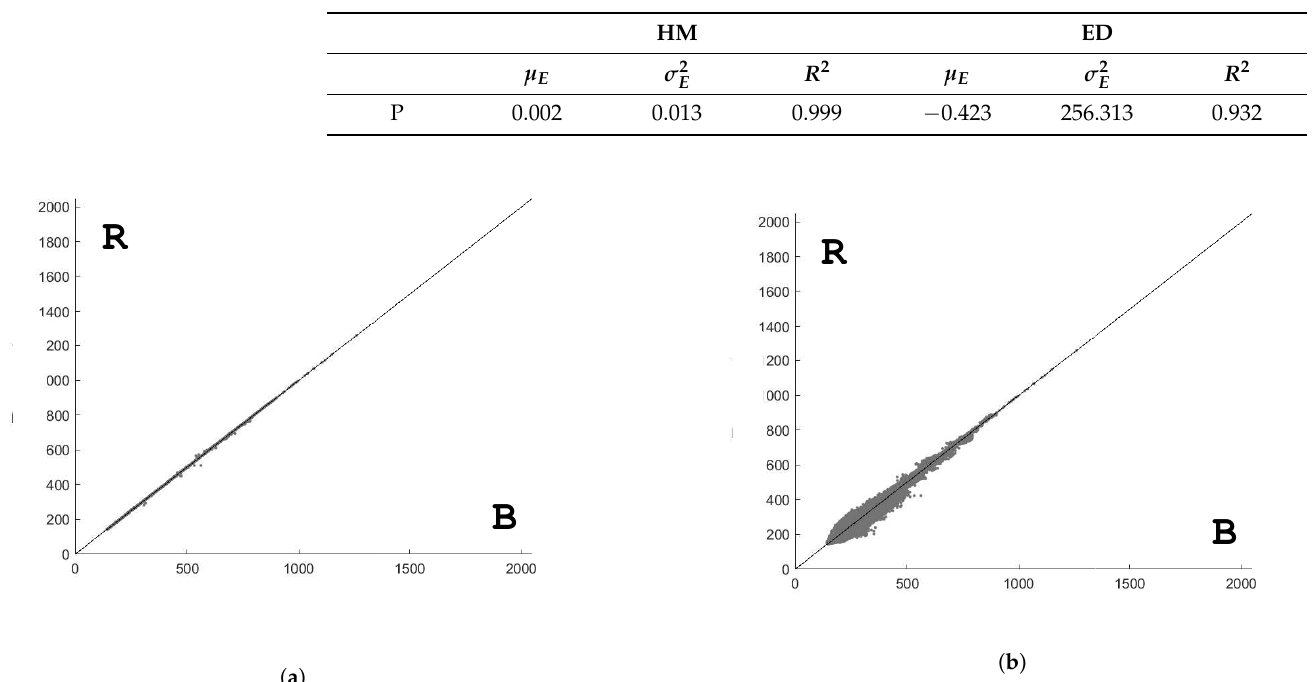
Table 1. Error characteristics of panchromatic self-validation tests with ( α , λ ) = ( 4000,20 ) ; mean of intensity differences, variance of intensity differences, coefficient of determination.